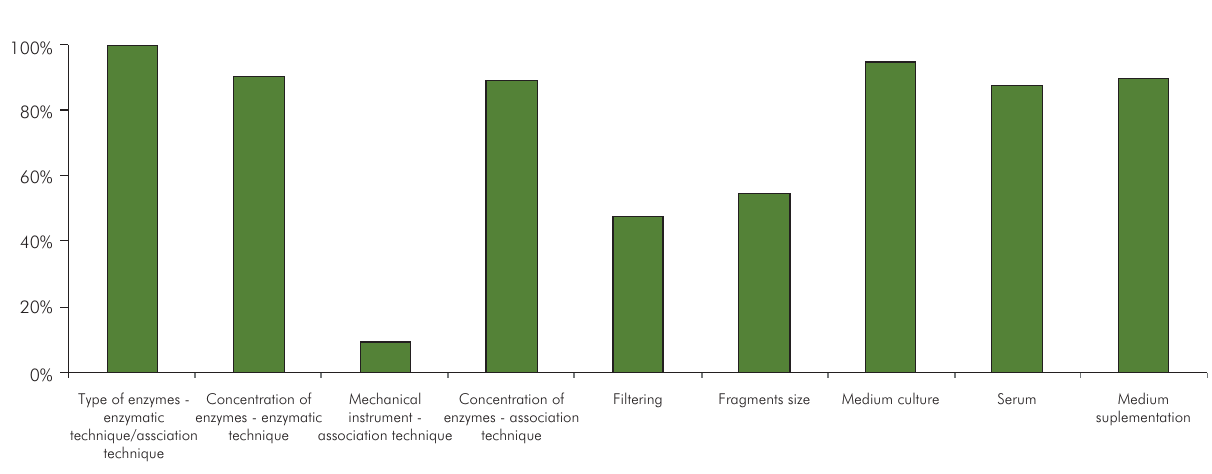
Type of enzymes - enzymatic technique/assciation technique Figure 2. Risk of bias considering aspects reported in the material and method section.